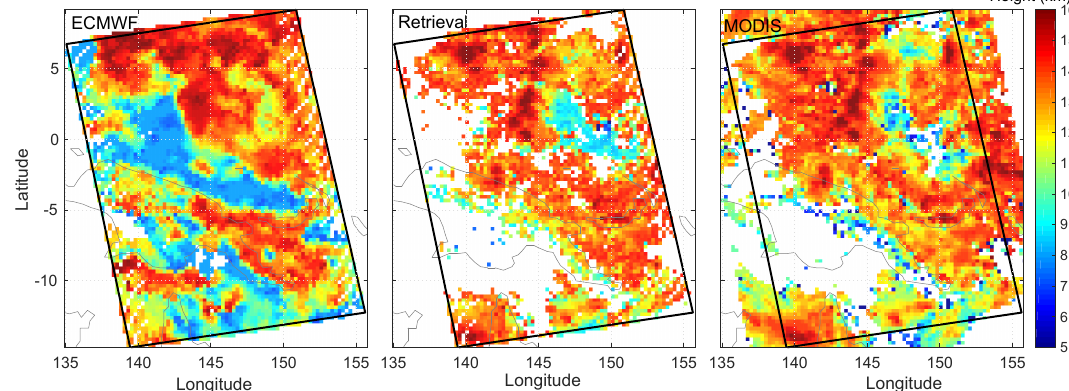
Figure 17. Comparisons between cloud top height: (left) original ECMWF ice cloud top; (center) ice cloud top heights used in the retrieval (ice clouds with optical depth < 0 . 5 have been removed); (right) MODIS L2 ice cloud top heights; the black lines outline AIRS Granule 039. It is clearly evident that the initial cloud tops from ECMWF were reset by our algorithm to closely resemble the MODIS-retrieved cloud tops; also note the similarity to the observed BT1231 in Fig. 9. Generally the low ECMWF cloud heights are associated with very low optical